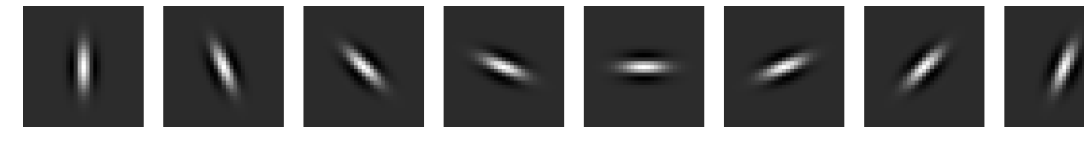
Figure 1. Two-dimensional Gabor kernels with different orientations, from left to right: 0, π /8, π /4, 3 π /8, π /2, 5 π /8, 3 π /4, and 7 π